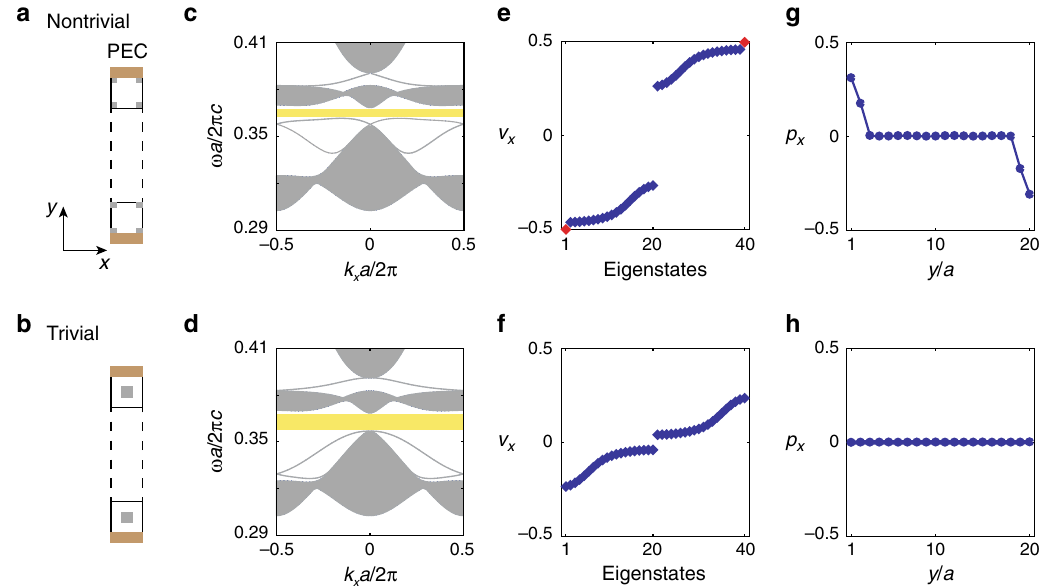
Fig. 3 Physical consequences of quadrupole topological PhCs at 1D interfaces. a , b Two 1D interfaces are created between a strip of quadrupole (trivial) PhC (same as Fig. 1b,c) and perfect electric conductors (PECs). c , d Energy dispersions of the two strip setups. e For the non-trivial setup, Wannier centers of the eigenmodes show two Wannier states at ±0.5, which are outside the bulk Wannier bands owing to the non-trivial bulk quadrupole moment. f In comparison, no in-gap Wannier states are observed in the trivial setup. g Calculation of the spatial density of polarization p x ( y ) shows the in-gap Wannier states are localized at the top ( y = 20 a ) and bottom interfaces ( y = 0). h Similar calculations repeated for the trivial PhC, showing no edge polarization, which is consistent with the trivial quadrupole